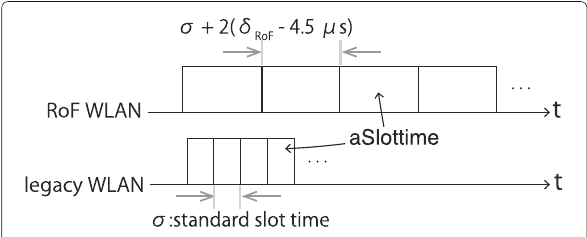
Fig. 4 Backoff time in slot time adjustment scheme. Backoff time of the RoF-based WLAN becomes much larger than that of the legacy